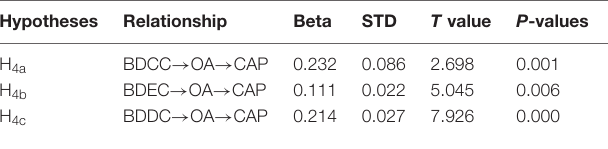
TABLE 5 | Structural model assessment indirect effect (mediation effects).